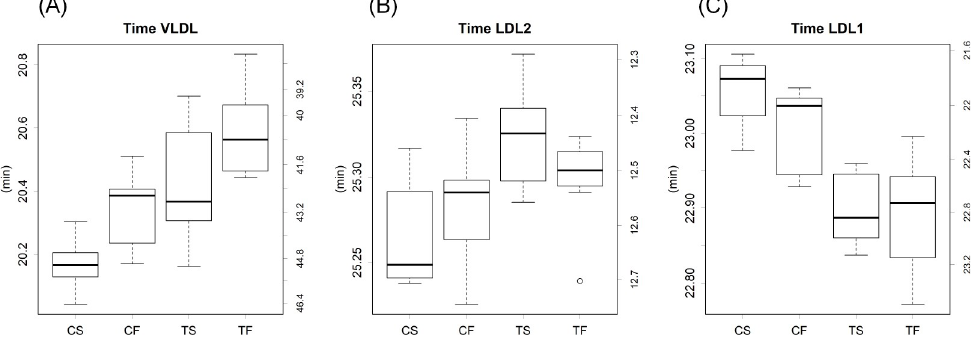
Fig 4. Elution times of lipoprotein classes. ( A ) VLDL, ( B ) LDL2, and ( C ) LDL1. C, casein; T, tofu; S, soy oil; F, fish oil. The bottom and top of the box are the first and third quartiles, respectively, and the band inside the box indicates the second quartile. Small circles show outliers. Results of statistical analyses are presented in S1 Appendix.